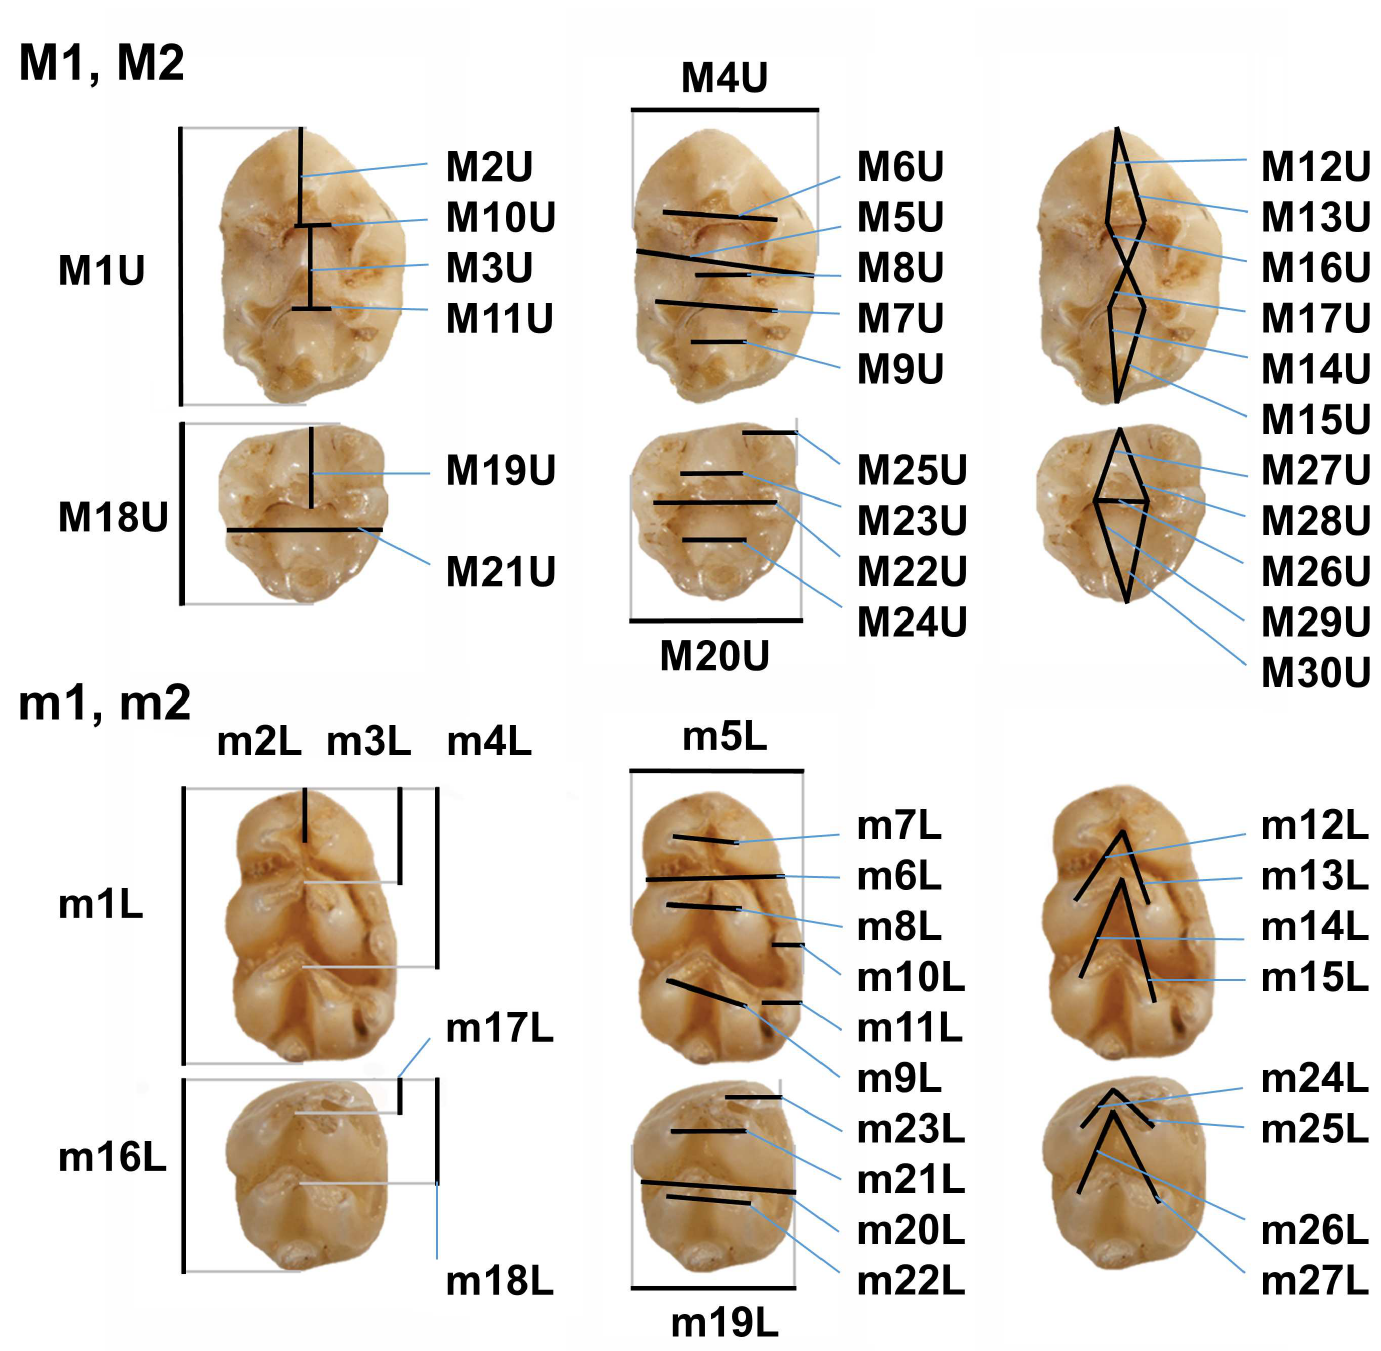
Fig 2. Definition of the metric characters applied in this study.